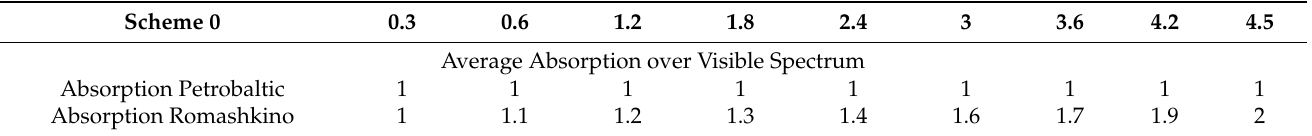
Table 1. Light attenuation by absorption.